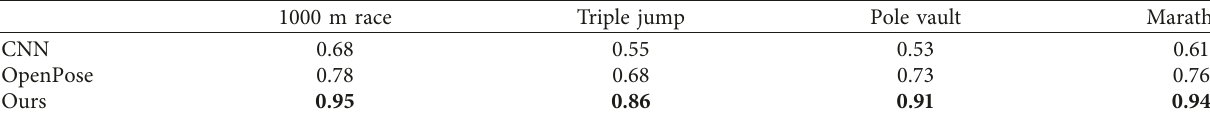
Table 4: Comparison of the accuracy of human pose estimation in different sports